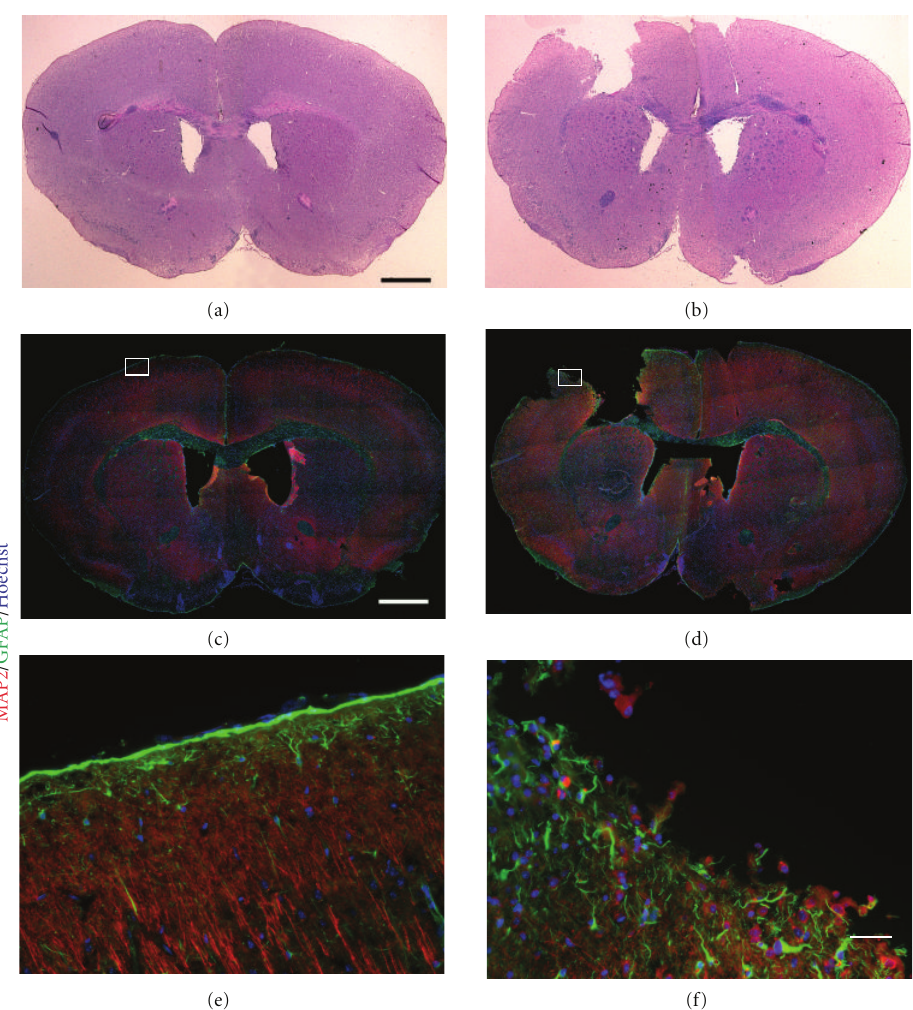
Figure 7: Cellular architecture in normal and injured motor cortices. (a)-(b) Hematoxylin and eosin (H&E) staining of coronal sections from mice subjected to sham surgery (a) and motor cortex injury (b). (c)-(d) Mosaic confocal images of adjacent sections show MAP2- (red) positive neurons and GFAP (green) astrocytes in sham (c) and injured (d) brains. (e)-(f) Higher magnifications of the insets in (c) and (d). In contrast to the well-organized architecture in the control motor cortex (e), there was a significant loss in the number of neurons, associated with an increase in astrogliosis in the injured cortex. Hoechst (blue) was used to label the nuclei. Scale bars: 1000 μ m (a)–(d), 100 μ m